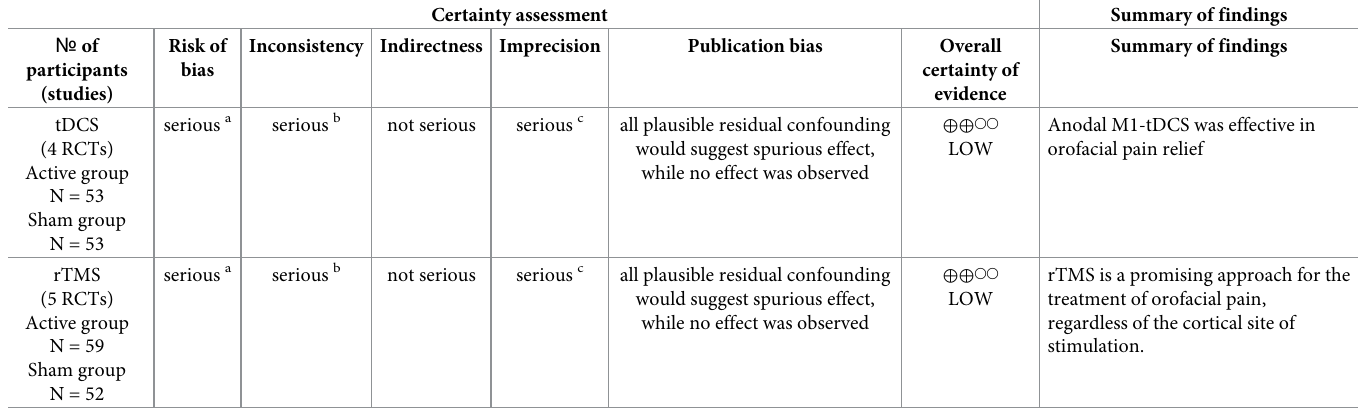
Table 5. Quality of evidence of non-invasive neuromodulation for the treatment of orofacial pain. Certainty